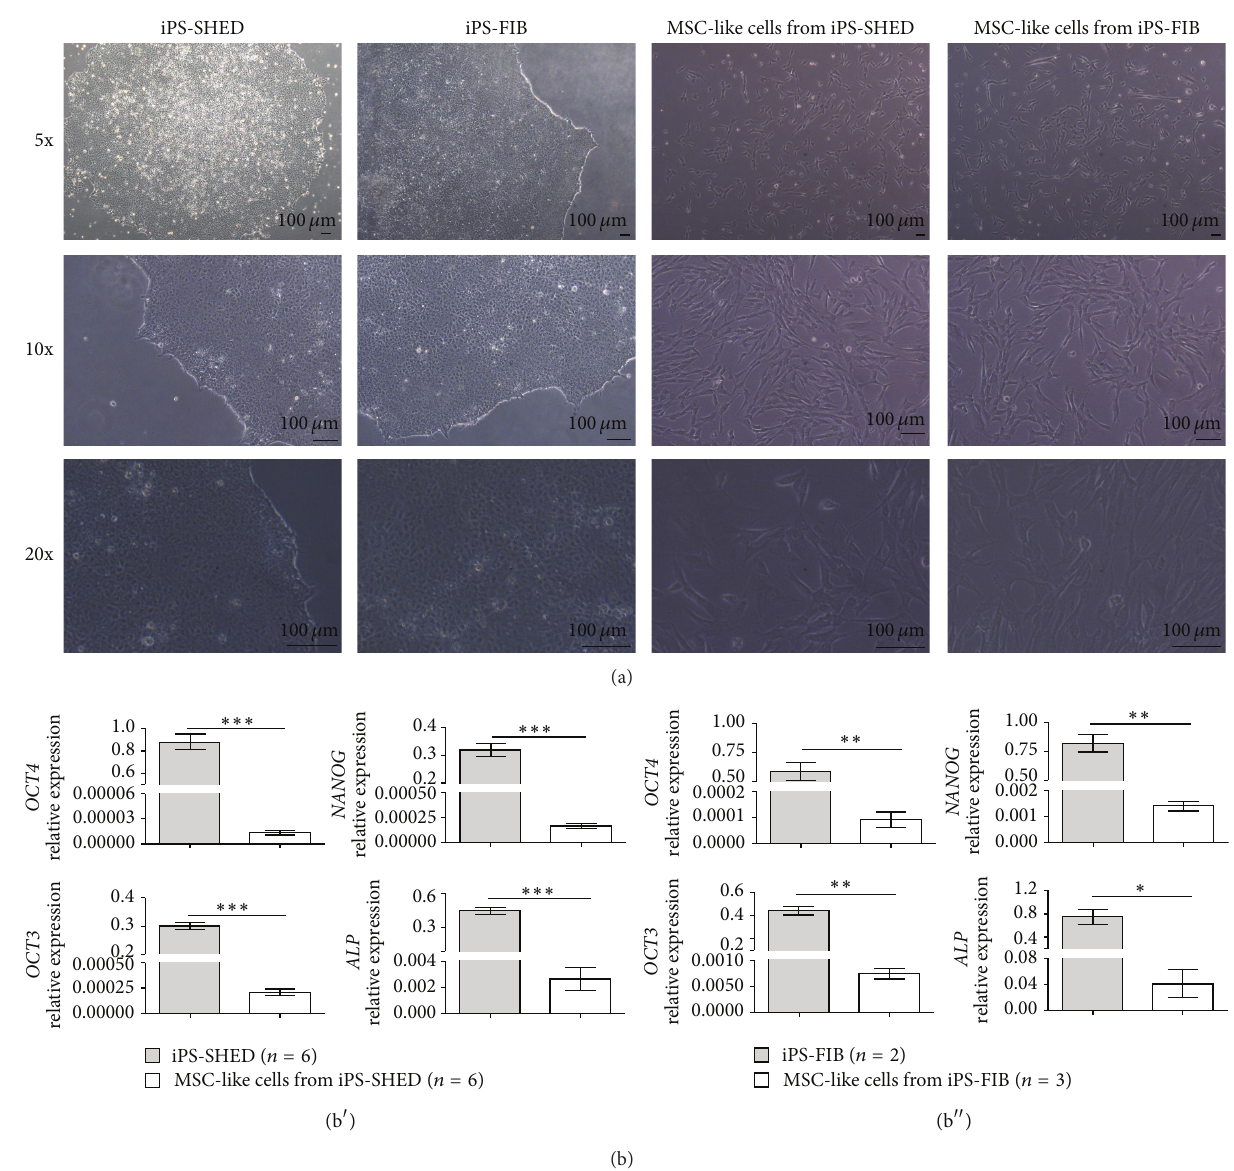
Figure 1: (a) Morphology of undifferentiated hiPSC colonies cultured on matrigel and MSC-like cells from iPS-SHED and iPS-FIB after 12 days of in vitro mesenchymal induction. Scale bar = 100um. (b) Real-time quantitative PCR analysis of pluripotency markers in undifferentiated hiPSCs ((b 󸀠 ) SHED and (b 󸀠󸀠 ) fibroblasts) and in MSC-like cells from iPS-SHED and from iPS-FIB. ACTB , TBP , and HMBS were used as endogenous controls. Values represent means +/ − SD, 𝑃 < 0.05 ( ∗ ), 𝑃 < 0.01 ( ∗∗ ), and 𝑃 < 0.001 ( ∗∗∗